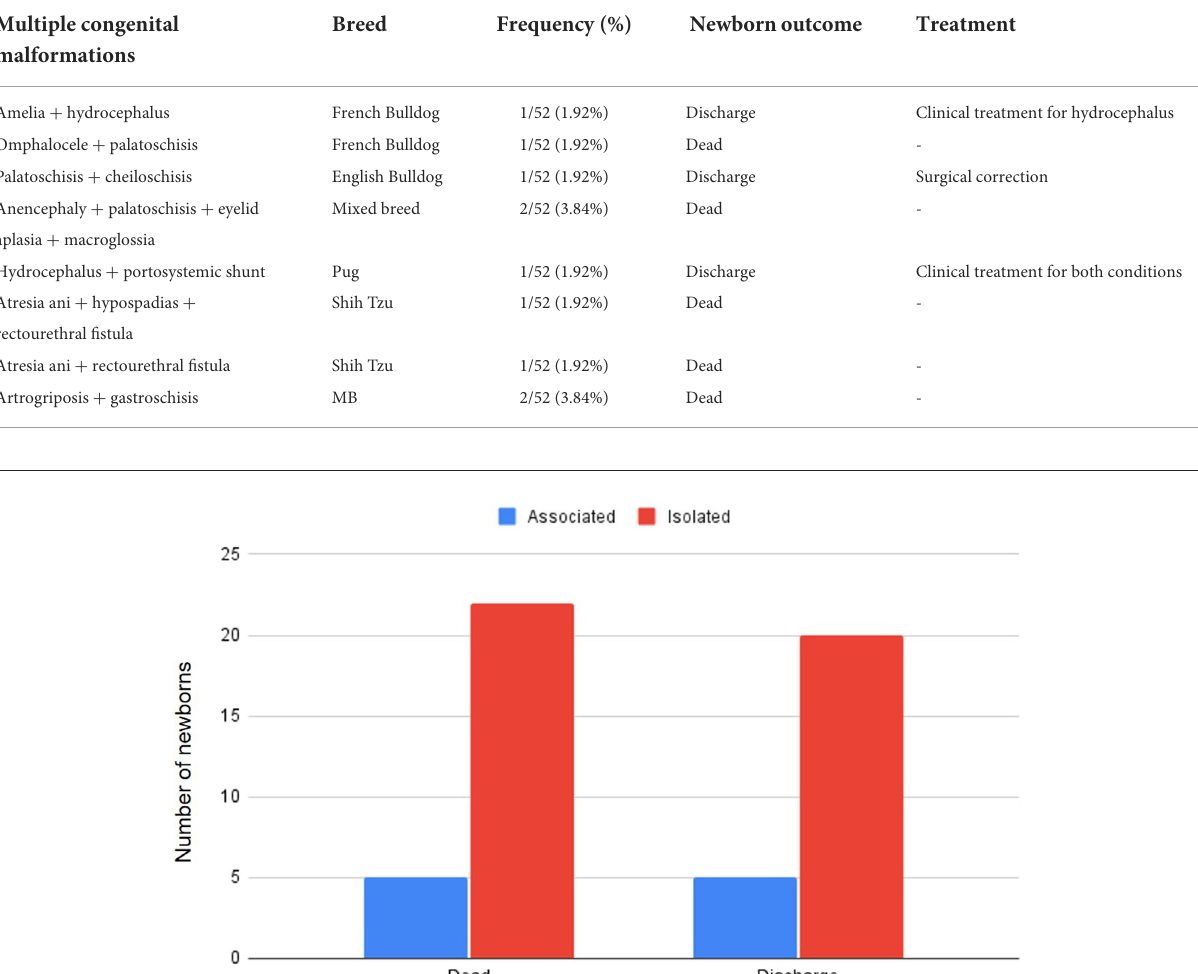
TABLE 2 Frequency, outcome, treatment, and description of associated congenital malformations by breed.